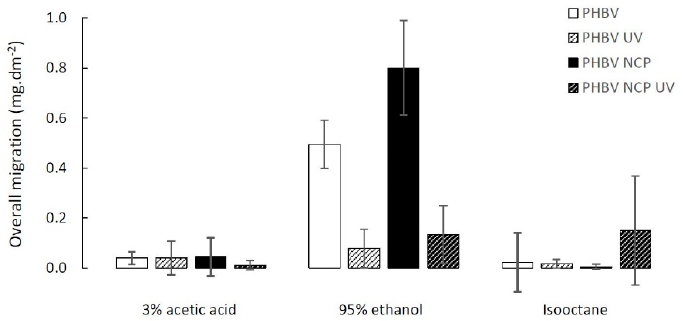
Figure 3. Overall migration of PHBV, PHBV NCP and the corresponding aged materials to the selected food simulants (3% acetic acid, 95% ethanol and isooctane).